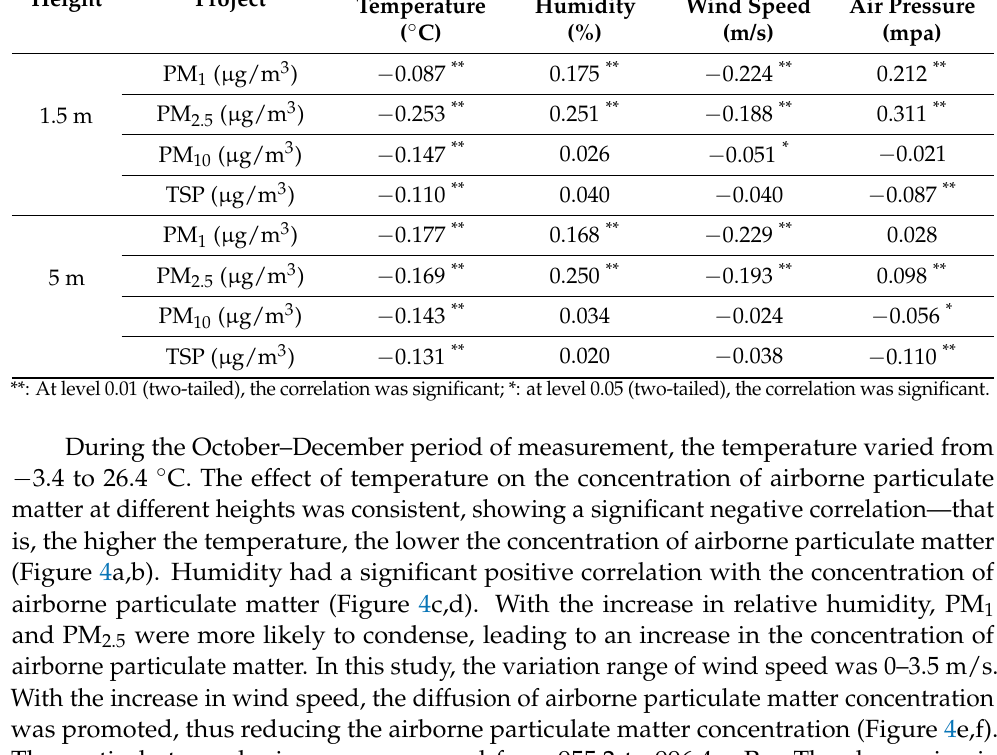
Spearman Correlation Test Temperature Humidity Wind Speed ( ◦ C) (%)